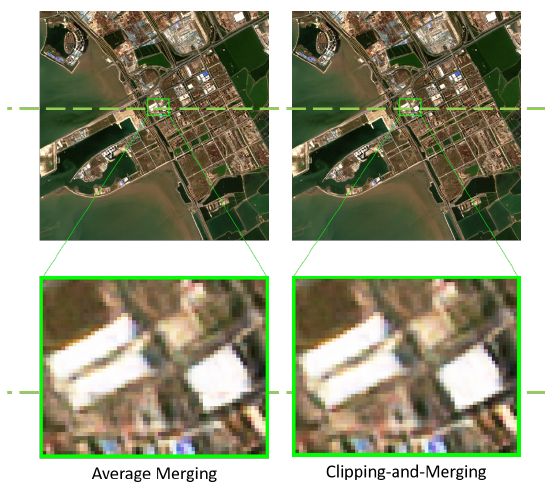
Figure 9. The merged image and the detail information. The left one is average merging result from ESRGAN output, and the right one is the result from clipping-and-merging method. Two green dashed lines refer to the position where they merge. One can hardly find the seam line between patches without supplement of dashed lines in our method, while there is a clear line in the other